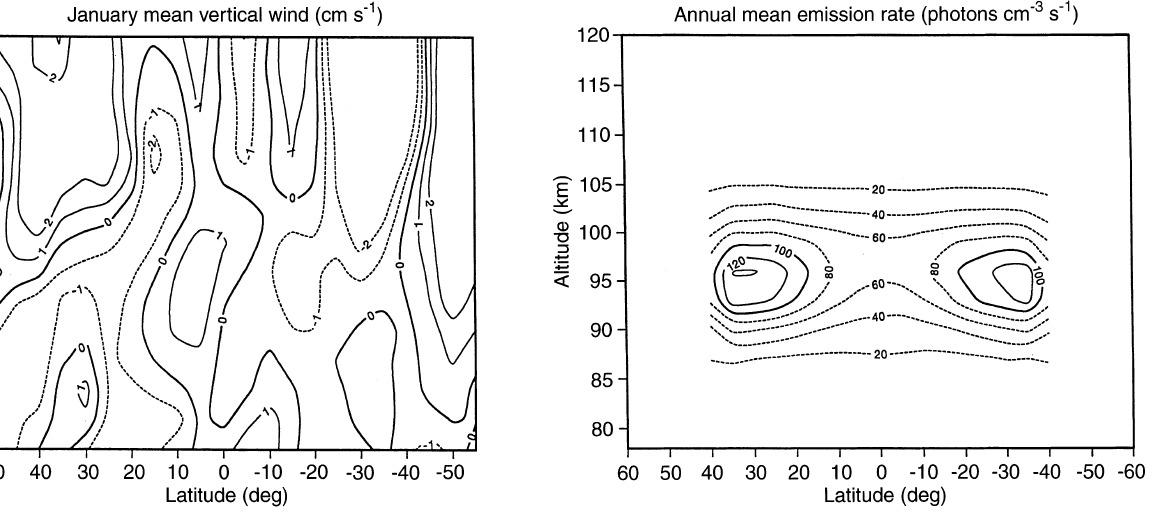
Fig. 9. Latitude-height distribution of the annual mean green-line